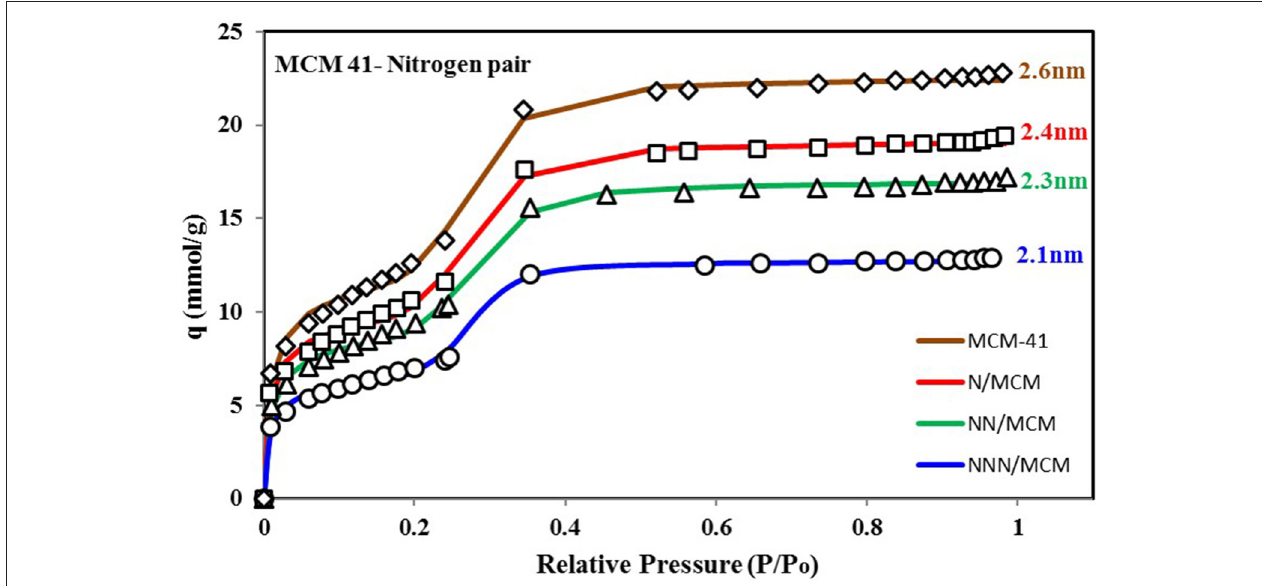
FIGURE 5 | Isotherms for MCM-41 variants with pore expansion when paired with nitrogen as adsorbate. The pore expansion caused an increase in uptake with the same response against relative pressure, which can be verified from the energy distribution plot with the same median energy level of all four variants.